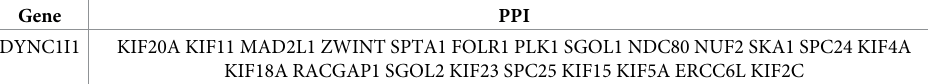
Table 1. Proteins that interact with